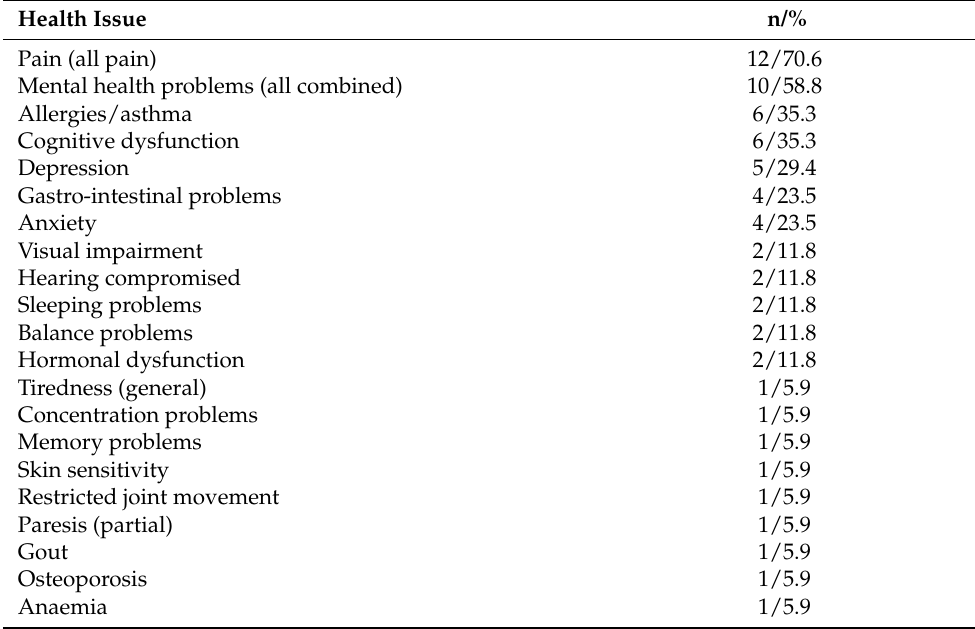
Table 3. Health issues reported by participants ( n =